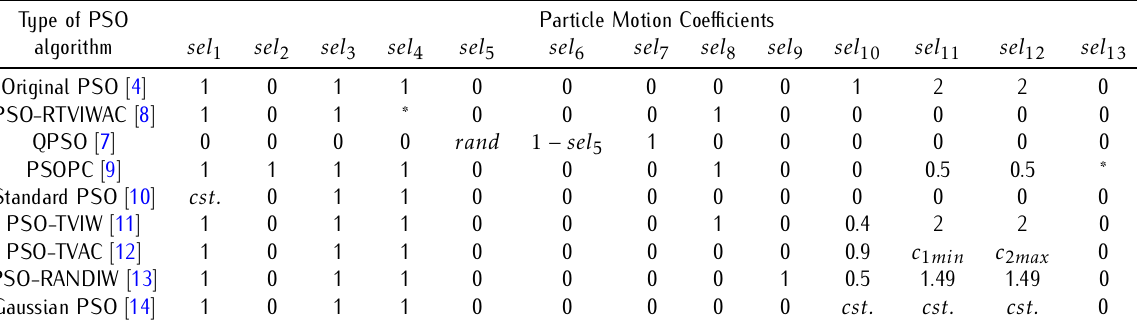
Table 1. The examples of particle motion coefficient for changing type of PSO